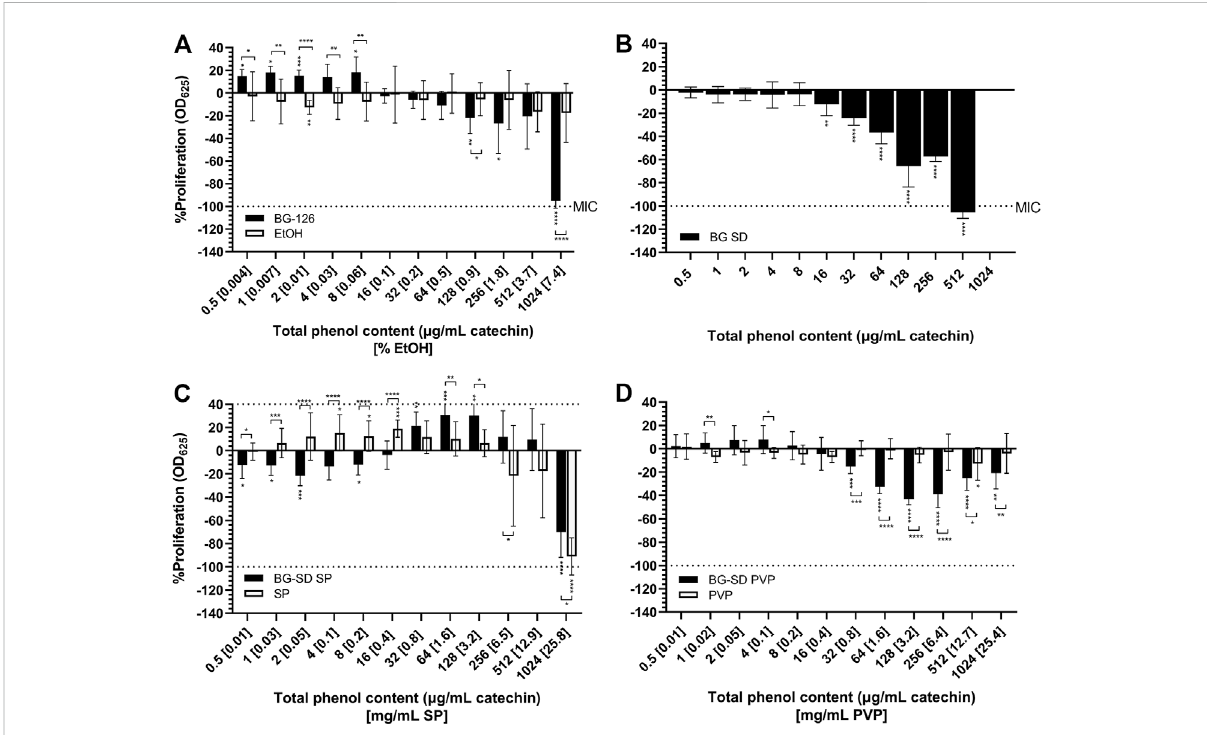
FIGURE 1 Effect of Buddleja globosa Hope (BG) extracts on the proliferation of Pseudomonas aeruginosa . P. aeruginosa was treated for 24 h with a hydroalcoholic BG extract (BG-126) (A) , spray-dried BG extract (BG-SD) (B) , spray-dried BG extract with Soluplus ® (BG-SD SP) (C) , and spray-dried BGextractwithPVP(BG-SDPVP). (D) Asterisksonbarsindicateastatisticallysigni fi cantdifferencewithrespecttotheuntreatedcontrol,andasterisks on brackets indicate differences between the BG formulations and the excipients. * p ˂ 0.05, ** p ˂ 0.01, *** p ˂ 0.01, and **** p ˂